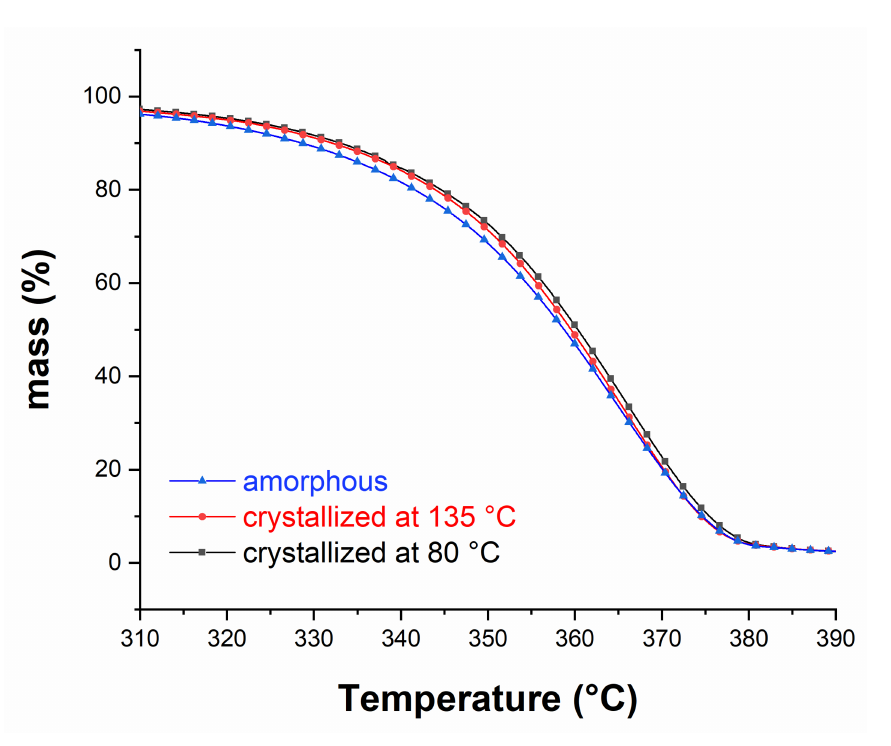
Figure 2. TGA curves of amorphous and semi-crystalline PLAs before